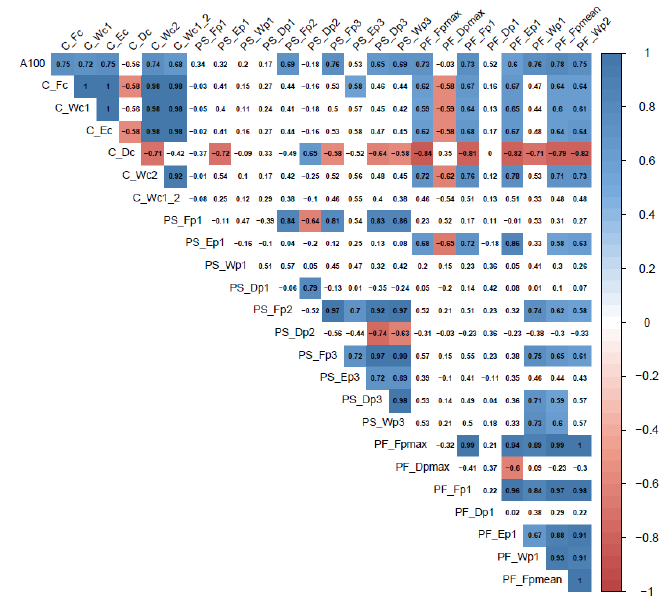
Figure 7. Pearson’s correlation coefficients ( p ≤ 0.05) between firmness measured by AGROSTA ® 100 (A100) and textural parameters issued from compression test (C), and puncture tests on the skin (PS) and on the flesh (PF). Non-significant values are blank.